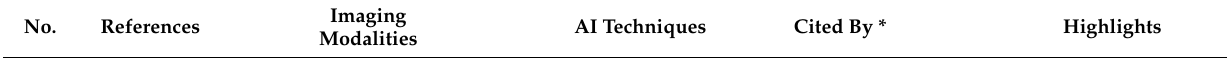
Table A1. Qualitative data distilled from each included review on imaging modalities, AI techniques, and the corresponding review